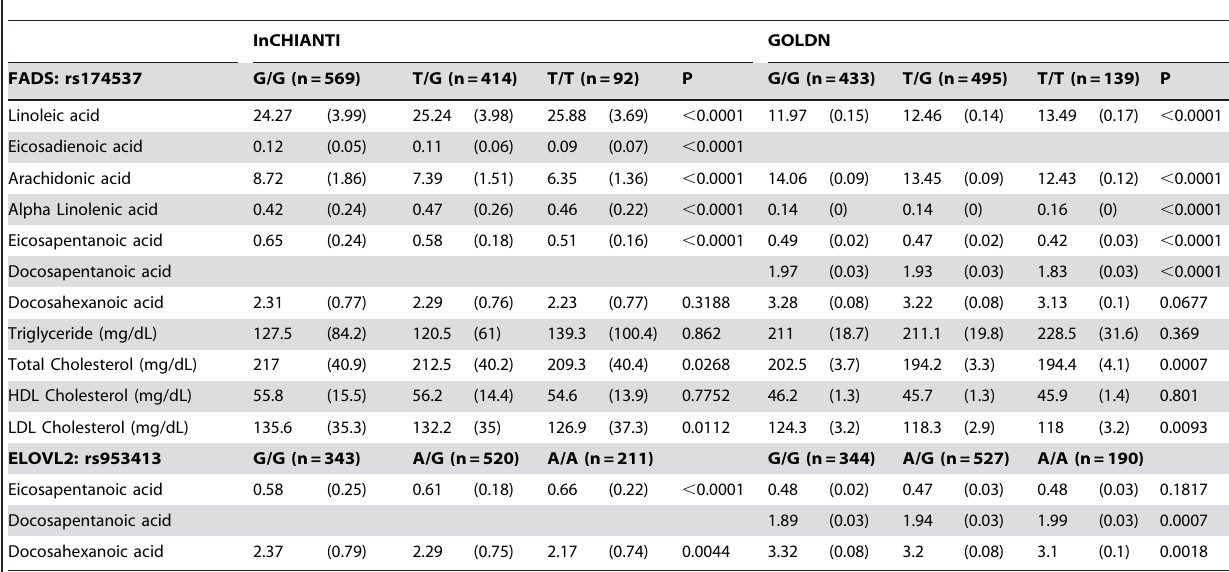
Table 2. Associations of fatty acids and plasma lipids by rs174537 ( FADS1 ) and rs953413 ( ELOVL2 ) in InCHIANTI and GOLDN study.